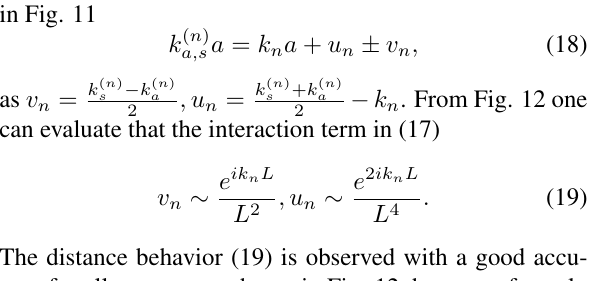
− k n . From Fig. 12